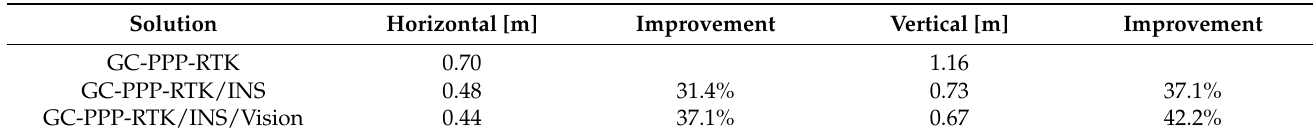
Table 5. RMS of the position difference of T02 with part of the epoch excluded in horizontal and vertical directions, respectively.